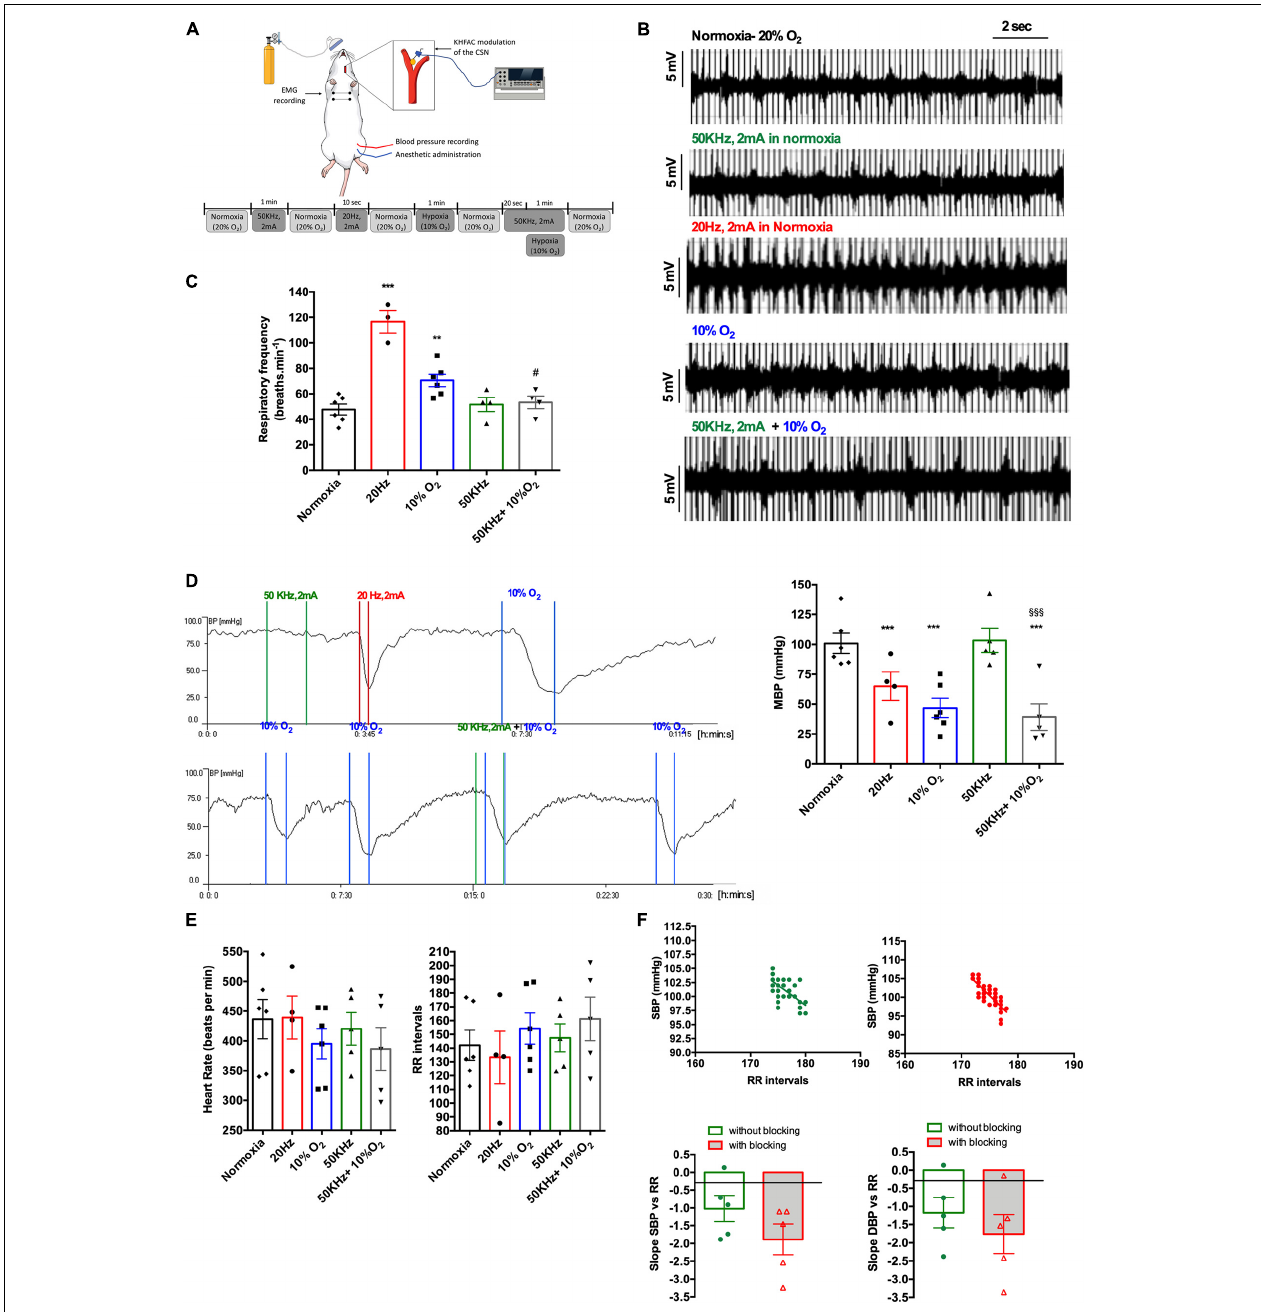
FIGURE 3 | Effect of acute CSN electrical modulation on baseline cardiorespiratory variables and the cardiorespiratory response to hypoxic hypoxia in anesthetized rats. (A) Schematic representation of the experimental setting and protocol used to evaluate the effect of electrical blocking of the CSN on the physiological variables; (B) panel shows, respectively, from top to bottom, EMG representative recordings of animals in normoxia ( n = 6; 20% O 2 balanced N 2 ), under electrical blocking ( n = 6; 50 kHz, 2 mA, 1 min), under electrical stimulation ( n = 6, 20 Hz, 2 mA, 10 s), in response to hypoxia ( n = 6, 10% O 2 balanced N 2 , 1 min), and under electrical block plus hypoxia ( n = 6; 50 kHz, 2 mA plus 10% O 2 ). (C) Shows the effect of CSN neuromodulation–stimulation (20 Hz, 2 mA, 10 s, n = 4) and blocking (50 kHz, 2 mA, 1 min, n = 4) on baseline respiratory frequency and respiratory frequency evoked by hypoxic hypoxia (10% O 2 balanced N 2 , 1 min, n = 6) expressed as bpm. (D) Left panel shows a typical recording of the effect of electrical blocking (50 kHz, 2 mA, 1 min) and stimulation (20 Hz, 2 mA, 10 s) of the CSN and the effect of hypoxic hypoxia (10% O 2 balanced N 2 , 1 min) on MBP measured at the femoral artery. Right panel show the mean values for the effect of electrical blocking on MBP in normoxia and hypoxia. Note that electrical blocking did not modify MBP and that CSN stimulation elicited a hypotensive response such as the produced by hypoxic hypoxia. The panel at the bottom shows the effect of blocking (50 kHz, 2 mA, 1 min) on MBP response to hypoxic hypoxia (10% O 2 balanced N 2 , 1 min). Note that electrical blocking of CSN does not seem to affect blood pressure response to hypoxic hypoxia. CSN electrical modulation was applied bilaterally to the CSN